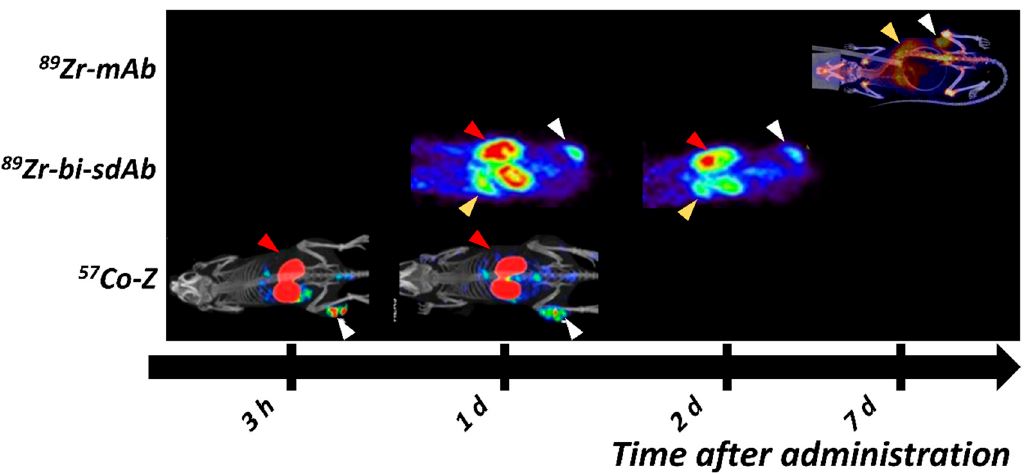
Figure 6. Imaging of HER3 expression (white arrows) in xenografted mice using 89 Zr-labeled mAb [252], biparatopic dimer of sdAb [259], and 57 Co-labeled affibody molecule ( 57 Co-Z) [265]. Yellow arrows point to the uptake in the liver and red arrows in the kidneys. These images were originally published in J Nucl Med [259] © SNMMI; PlosOne [252] and Int J Mol Sci [265].